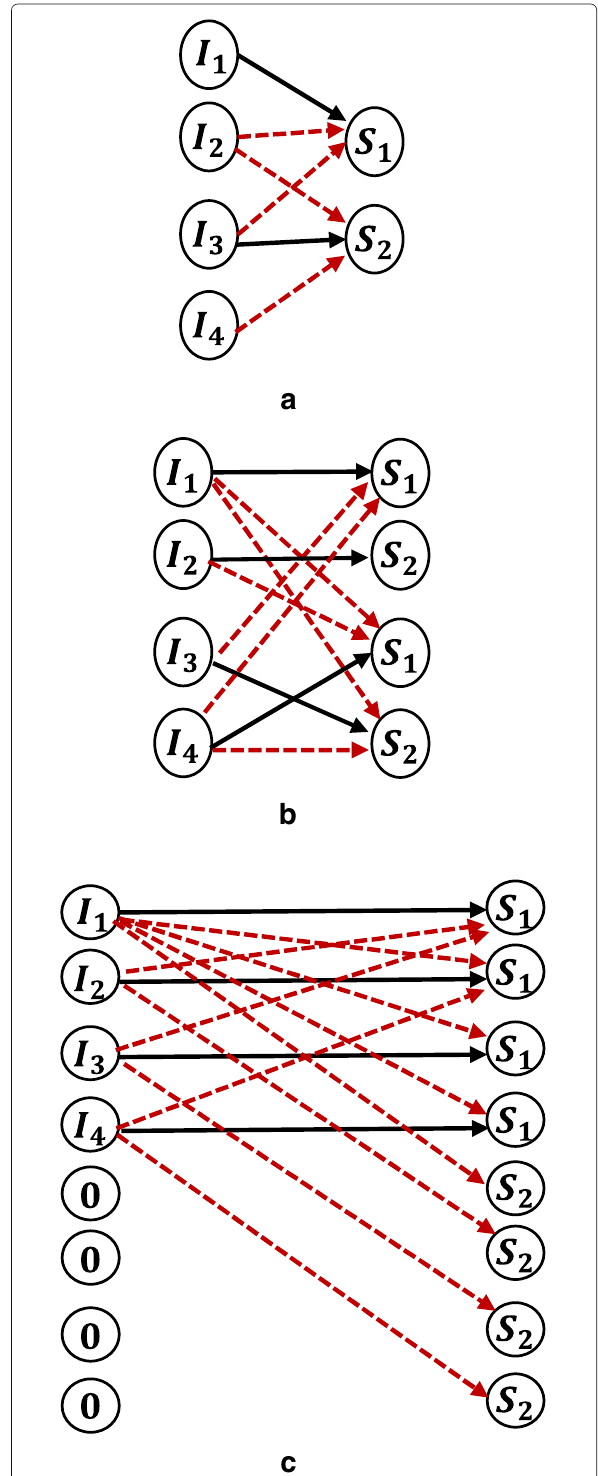
Fig. 2 Graphical representation of mapping between IoT devices and cryptographic schemes. a Initial bipartite graph, b Modified bipartite graph G (cid:6) , and c Final bipartite graph G (cid:6)(cid:6) to solve the assignment